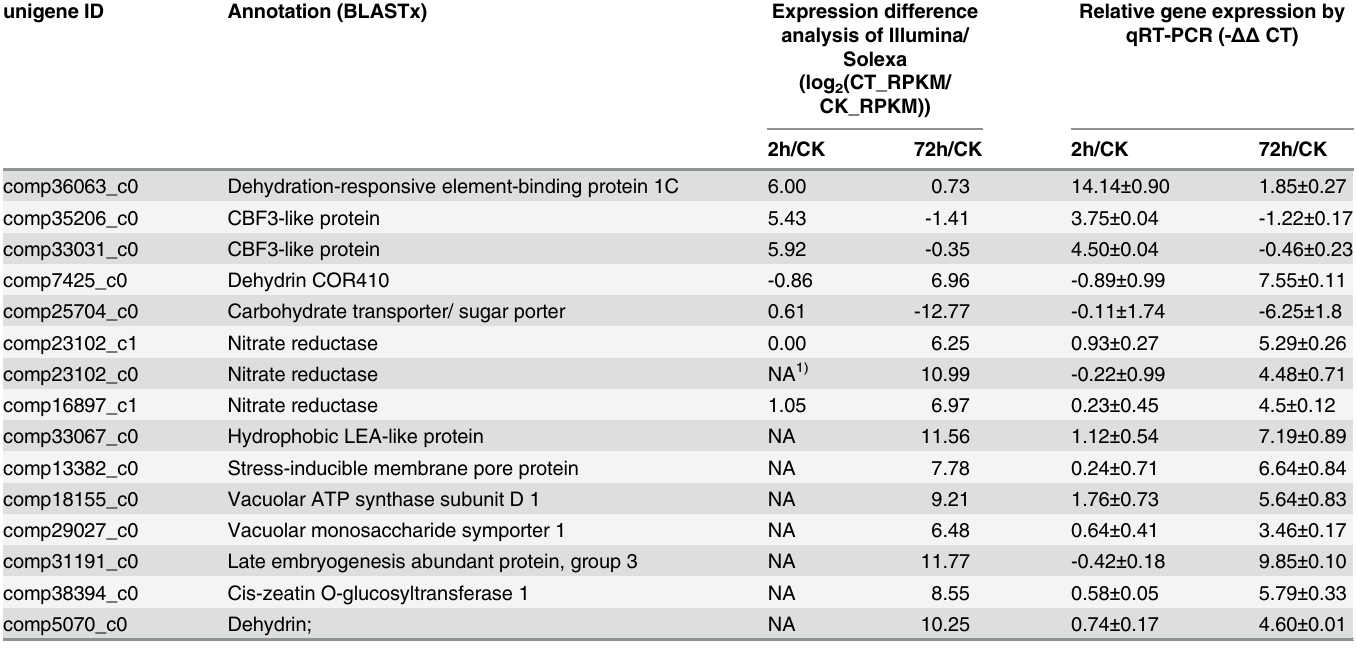
Table 4. Verification of RNA-seq results by qRT-PCR. unigene